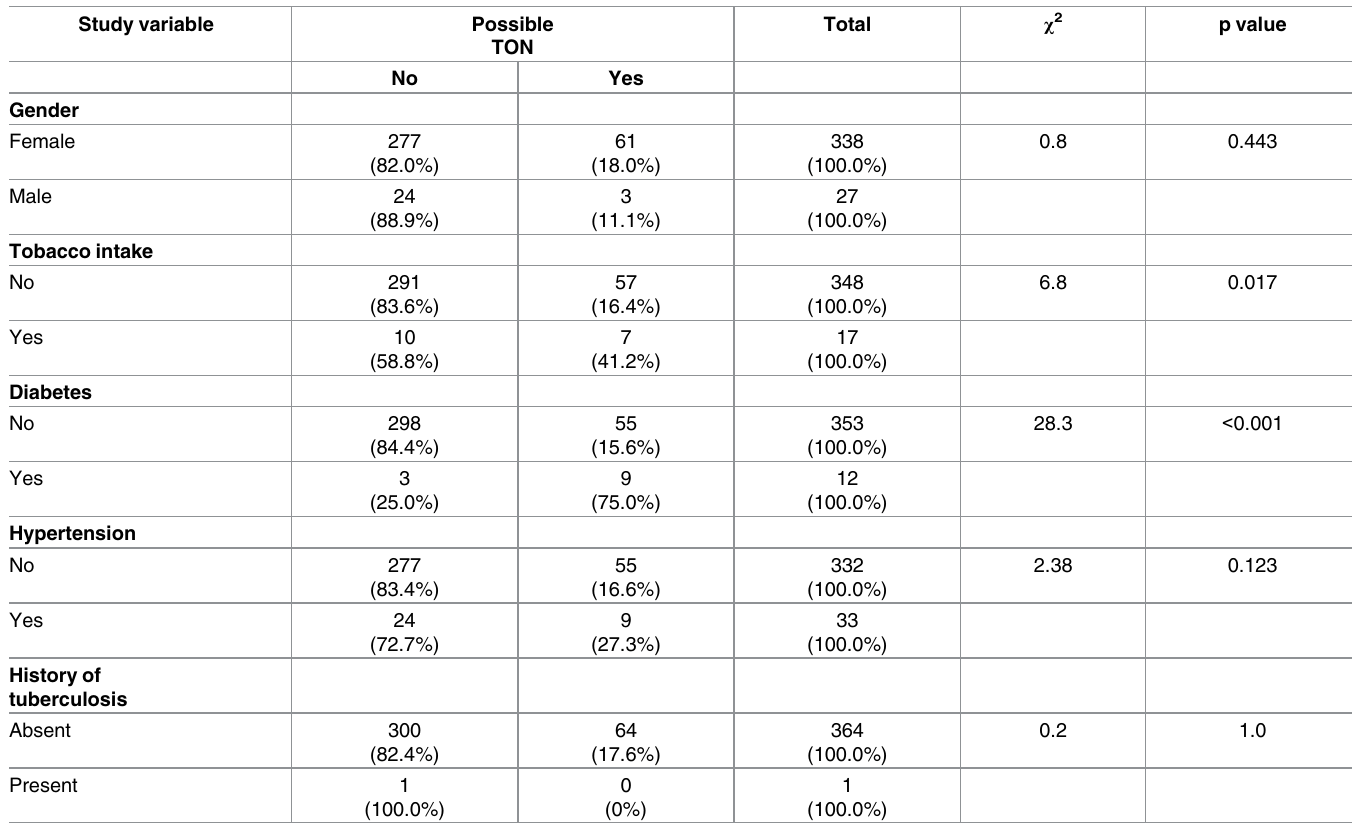
Table 2. Association between key demographic, biological, and occupational factors, and potential toxic optic neuropathy among beedi rollers in selected rural areas of Dakshina Kannada district, Karnataka, India, April-Sept 2016 (N = 365). Study